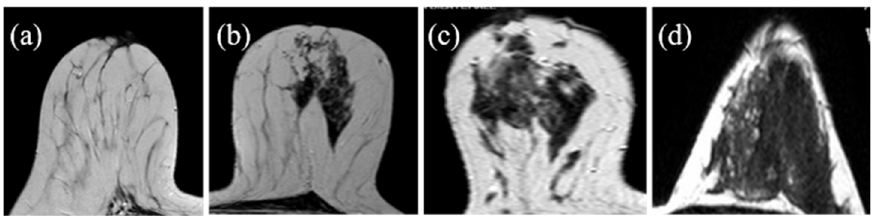
Figure 1. Fibroglandular tissue (FGT): ( a )almost entirely fat; ( b ) scattered fibroglandular tissue; ( c ) heterogeneous fibroglandular tissue; ( d ) extreme fibroglandular tissue.